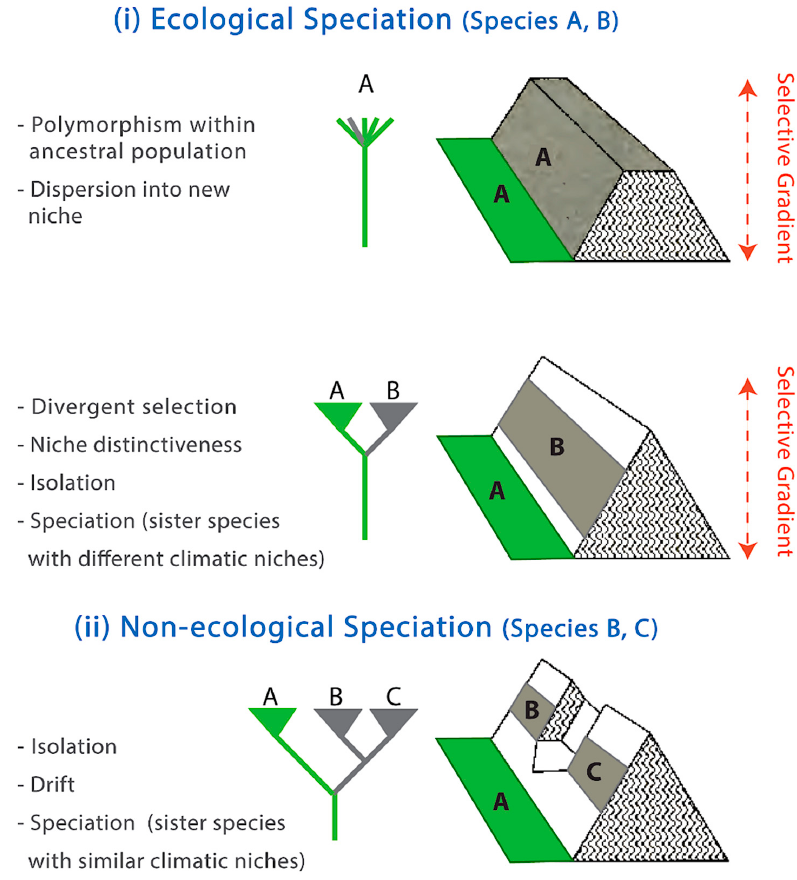
Figure 234. Speciation modes. ( i ) Ecological speciation in elevational gradients. ( ii ) Non-ecological speciation in the same elevational band.